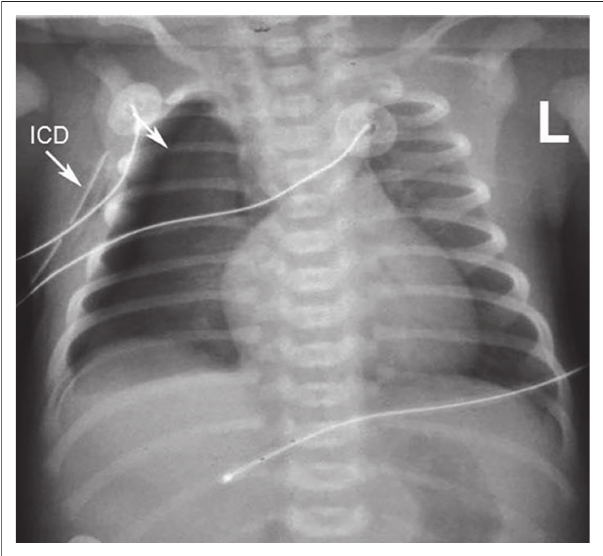
FIGURE 14: The left upper limb peripherally inserted central catheter (PICC) line (arrow) has been advanced too far and its end is within the right ventricle, close to the pulmonary outflow